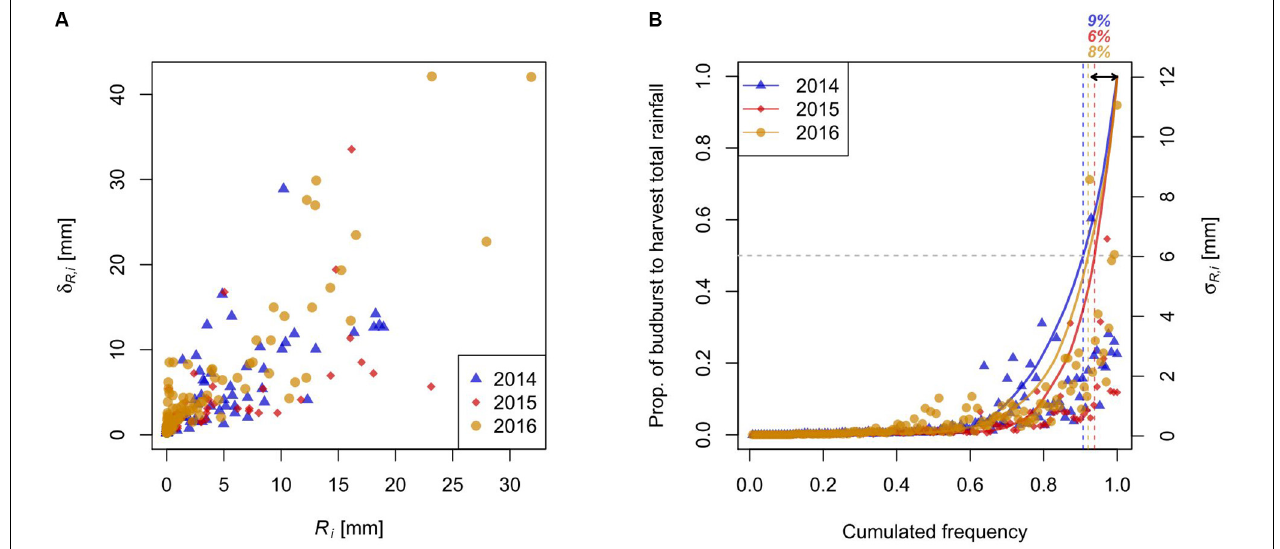
FIGURE 3 | Local rainfall variability at daily time step during the grapevine vegetative period. (A) Spatial precipitation range ( δ R , i , i.e., max.–min. rainfall collected by the rain gauges on a given day) as function of daily precipitation height ( R i , mm) averages the Hydravitis local scale network. (B) The lines show the proportion of total cumulated rainfall from budburst to harvest as function of the cumulated distribution of each rainy ( > 0 mm) event (i.e., day), and the dots show the daily standard deviation of rainfall ( σ R , j , i.e., daily spatial variability). The colored number on the top of the plot indicates the percentage of rainy days (range underlined by arrows) during the budburst to harvest period that bring 50% of the total cumulated rainfall for this period (area delineated by colored dashed vertical lines).